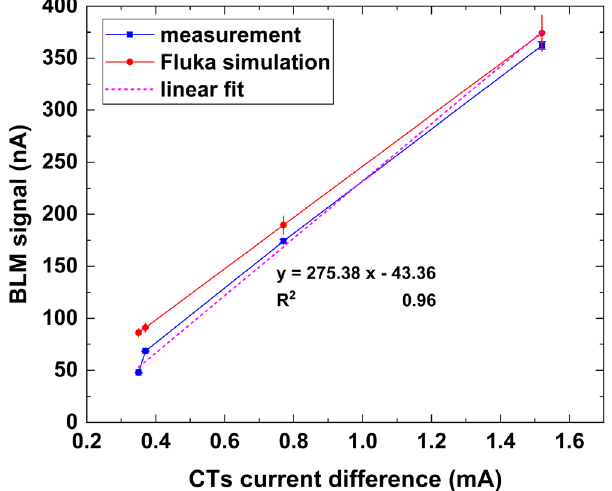
FIG. 16. Experimental and FLUKA simulated BLM signal in the mixed radiation field generated by the movable emittance monitor versus the beam current difference measured by